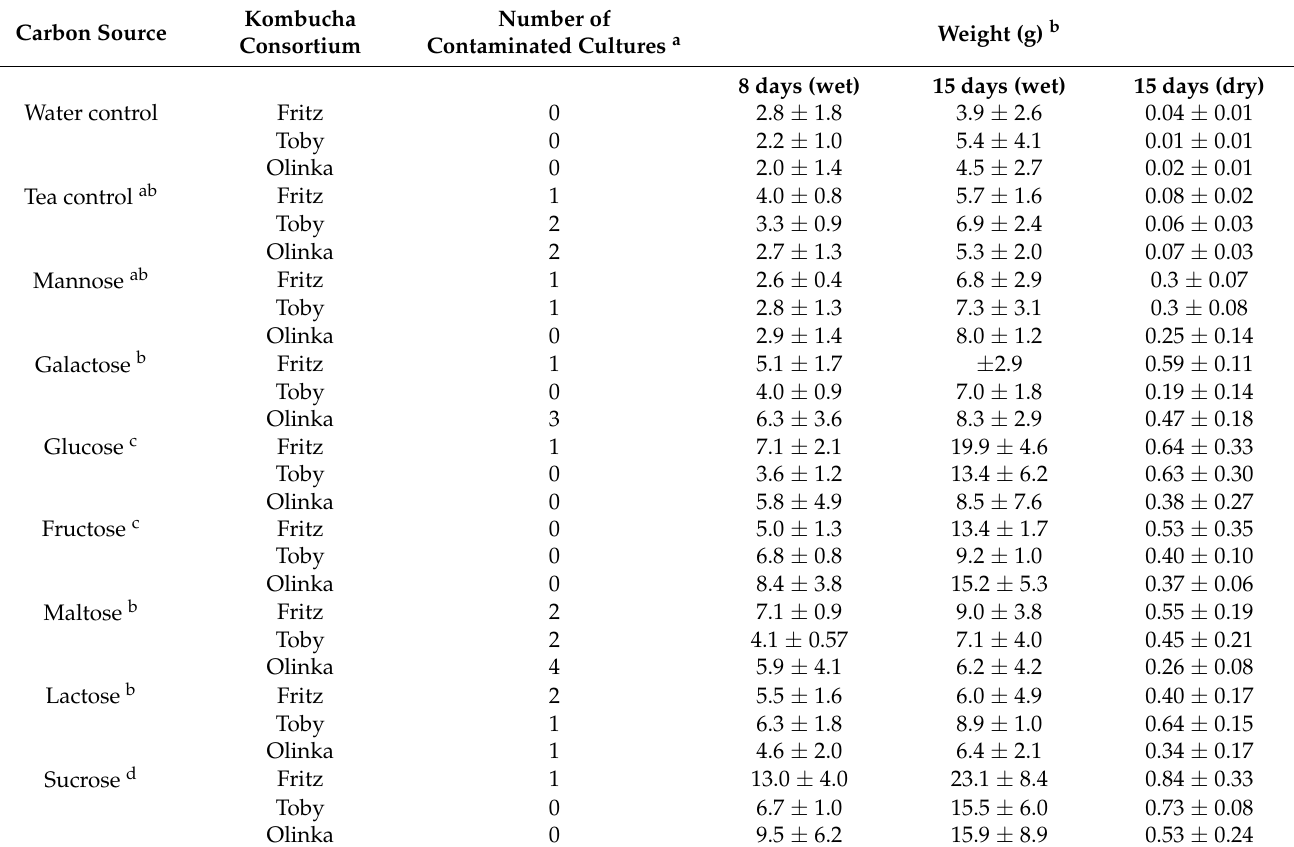
Table 2. Wet and dry weights (g) of nascent pellicles of three kombucha strains grown on tea amended with seven different sugars after 8 or 15